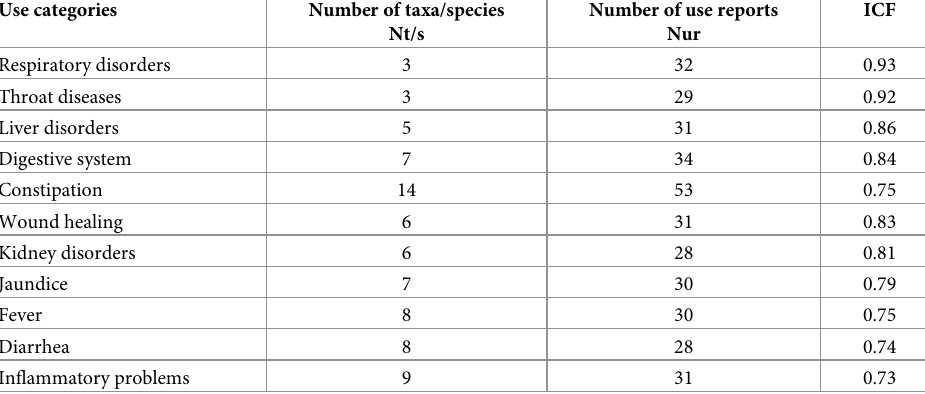
Table 3. Disease category cured through number of taxa/species, reports and informants consensus factor (ICF) for Head Maralla